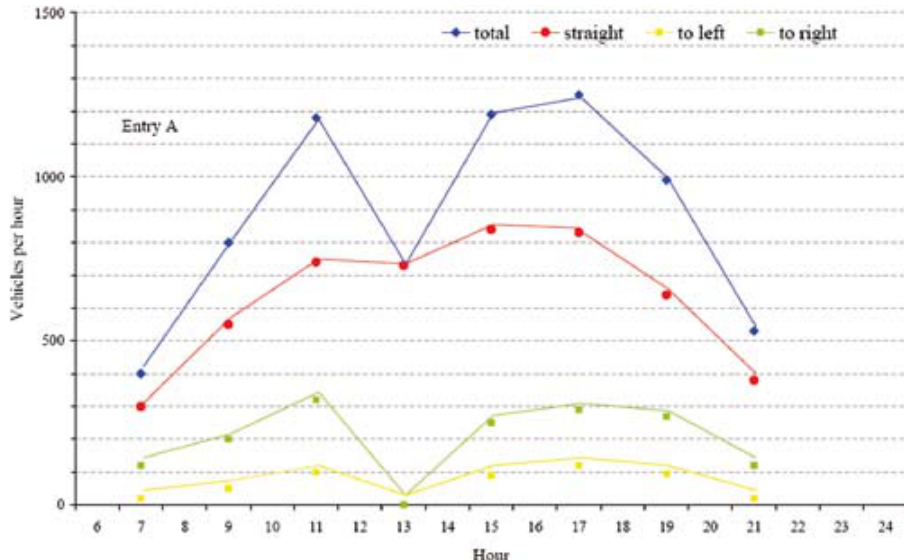
fig. 8. Graph of traffic